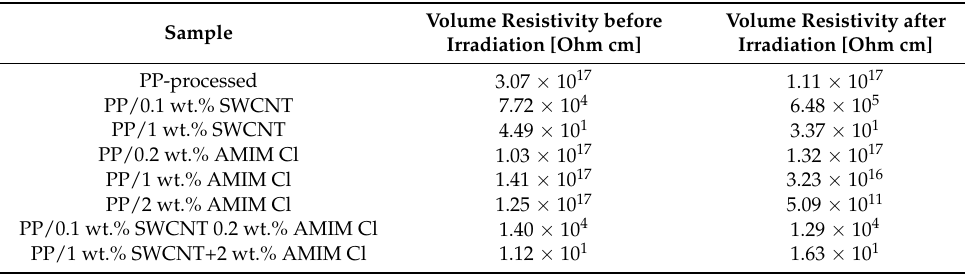
Table 1. Electrical resistivity values before and after electron beam irradiation of PP, PP/SWCNT, PP/IL and PP/SWCNT/IL composites; used IL: AMIM Cl, dose of 18 kGy.